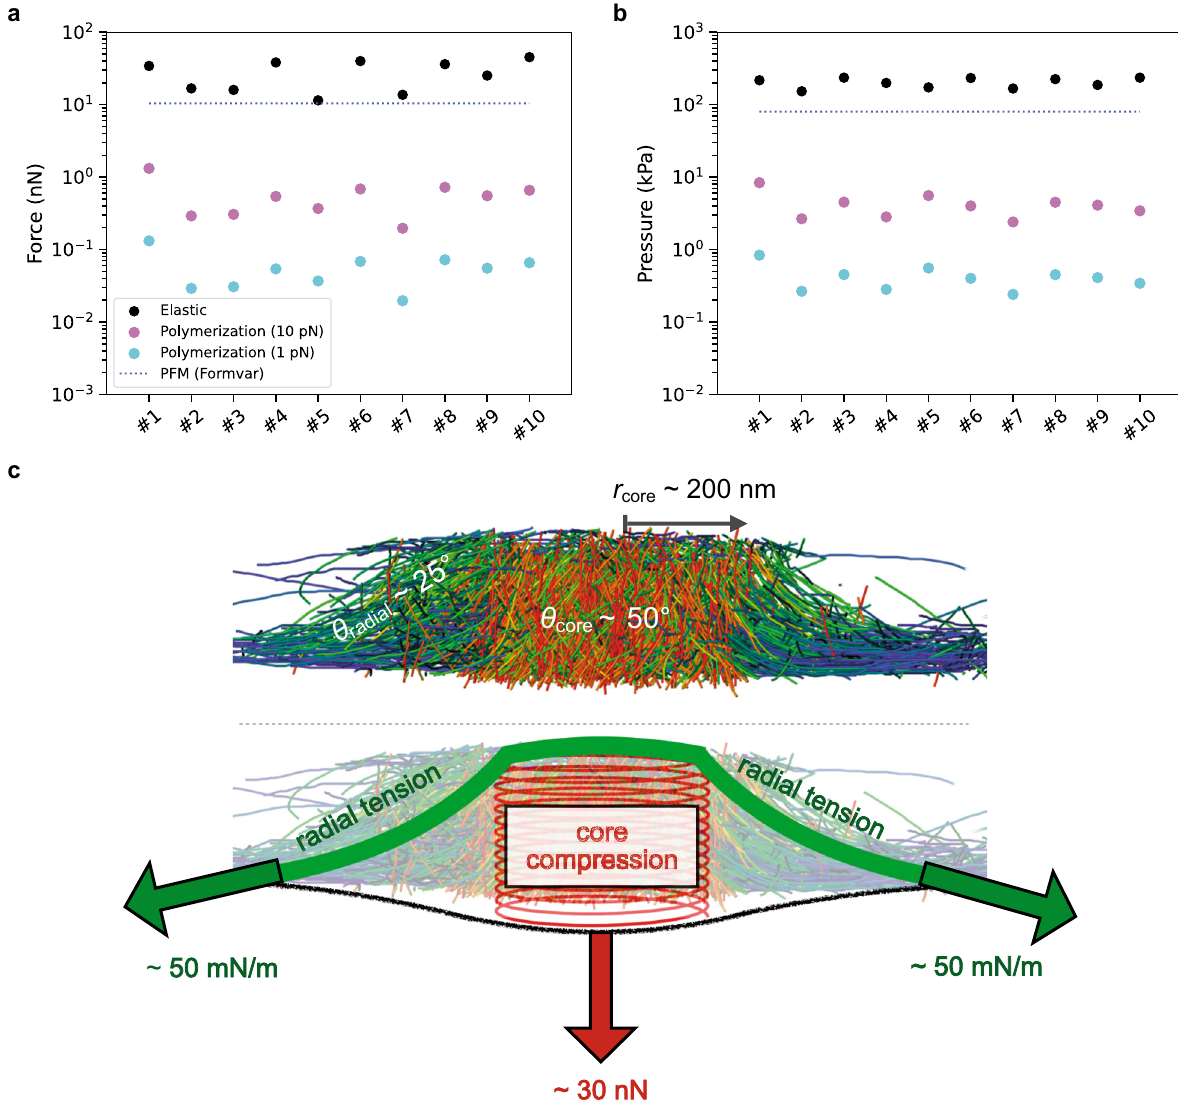
Fig. 4 The actin core generates elastic forces in the nanonewton range. a Comparison of the elastic force generated by the core through the compression of the actin network ( “ Elastic ” ; black) with the estimated polymerization force generated at the core membrane ( “ Polymerization ” ) with the upper ( “ (10 pN) ” ; purple) and lower ( “ (1 pN) ” , cyan) limits of the polymerization force. The blue dashed line corresponds to the mean force derived from PFM measurements on 30-nm thick Formvar fi lms ( “ PFM (Formvar) ” ) 17 . b Same comparison plot as in a for the estimated pressure assuming a perfect circular shape for the podosome core (Methods). c Summary scheme showing the podosome organization revealed by cryo-ET, the elastic force resulting from core compression and the radial surface tension counterbalancing it. The tension of the 2D meshwork of radial fi laments that is required to balance the core compression force is deduced from the mean radius of the core, r core , and the mean angle of the radial fi laments, θ radial , with respect to the membrane plane. Source data are provided as Source Data fi